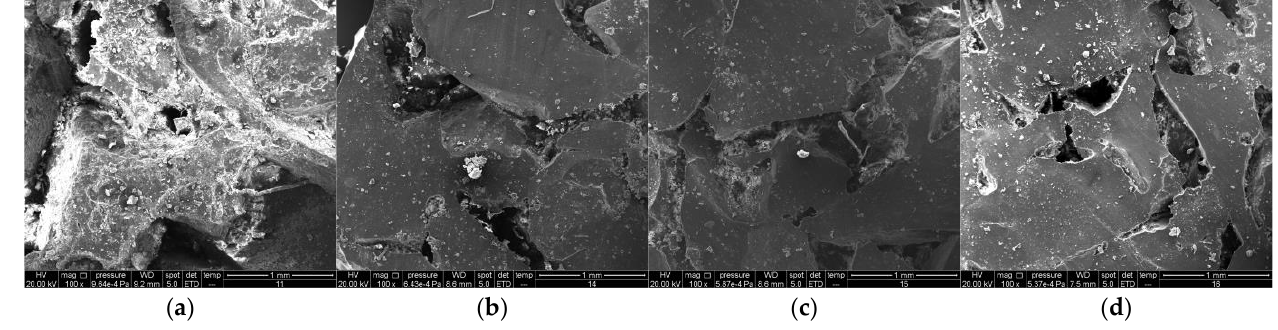
Figure 8. Morphology of black rubber substrate with immobilized 2 g of TiO 2 through three horizontal layers (100×): ( a ) surface; ( b ) first layer (2 mm); ( c ) second layer (4 mm); and ( d ) third layer (6 mm).